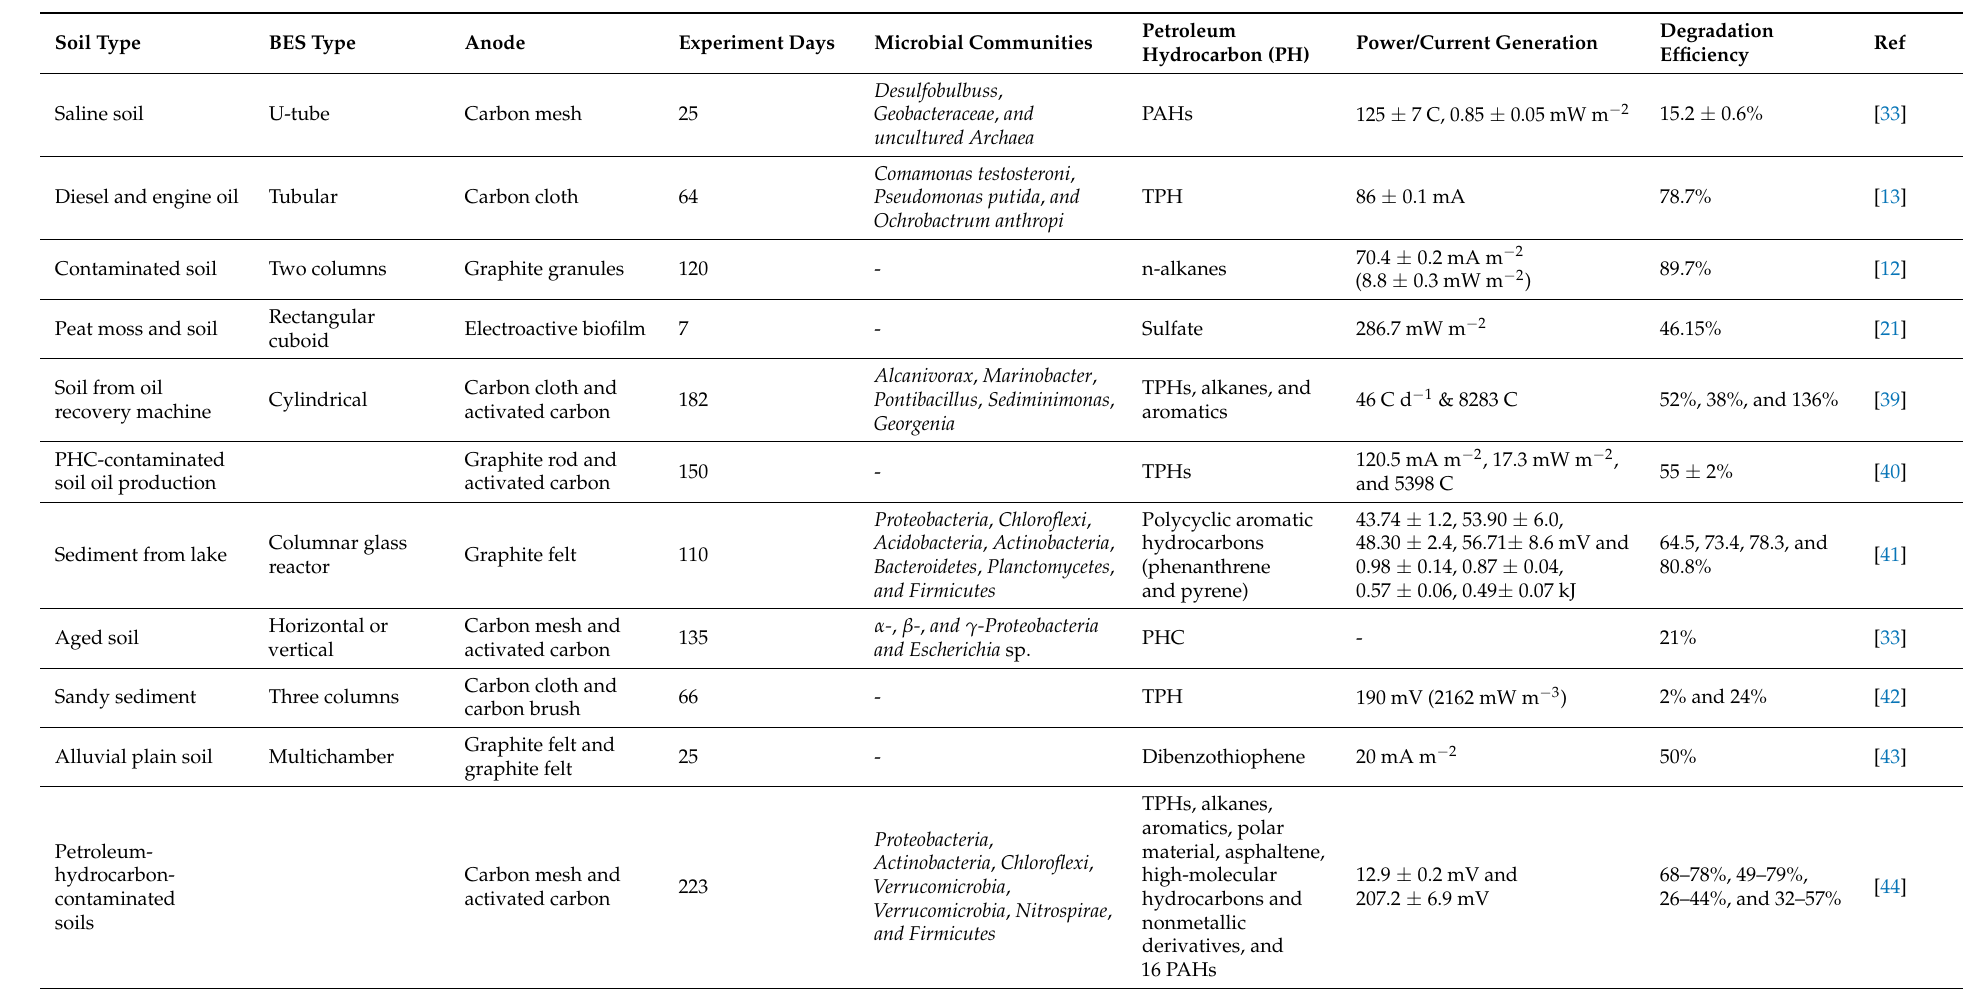
Table 1. Recent advancements in BES-based bioremediation strategies for PH-contaminated